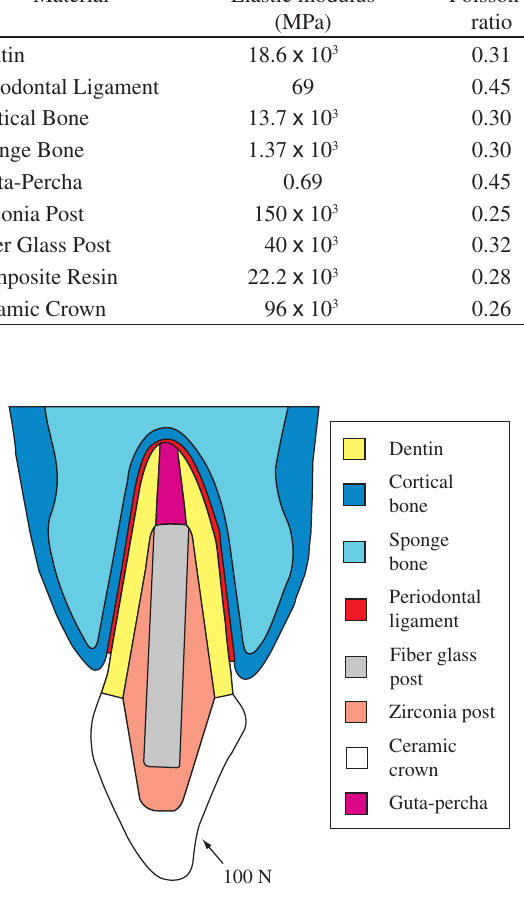
Figure 1. Zirconia post restored model. Figure 2. Fiber glass post restored model.